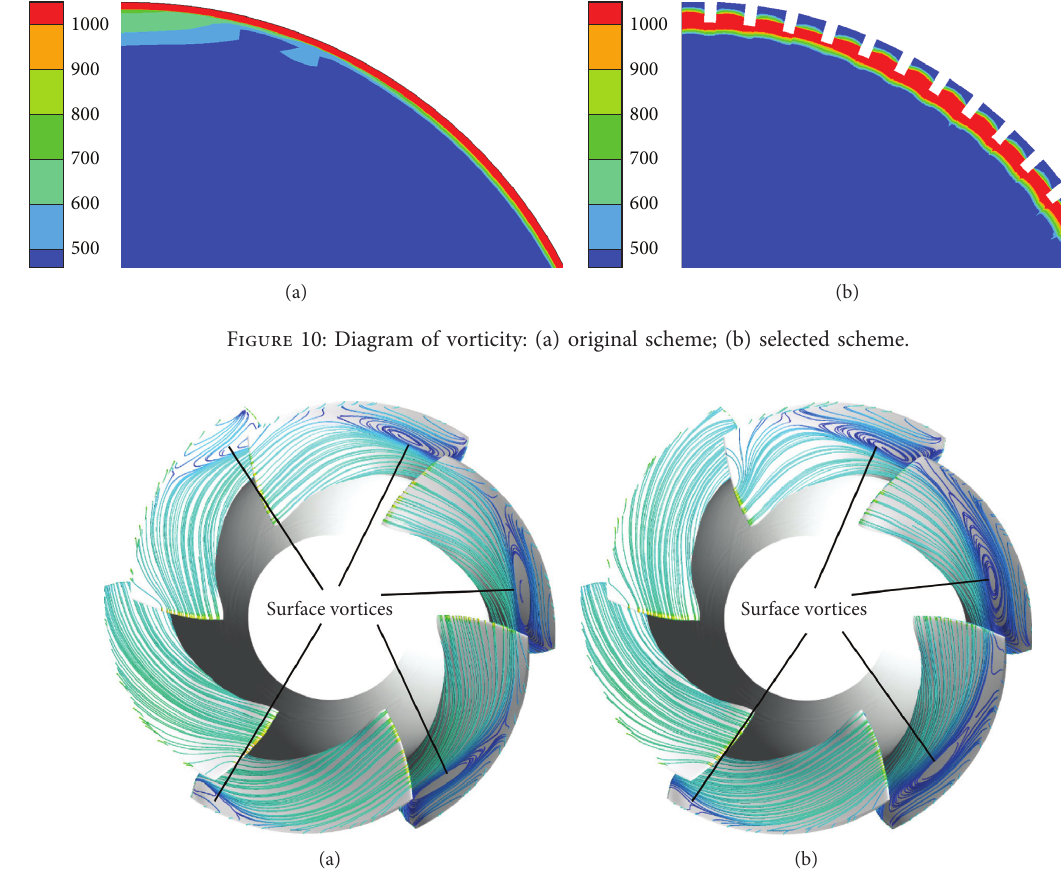
Figure 11: Streamlines on blade under 0.5 Q ′ condition: (a) original scheme; (b) selected scheme.